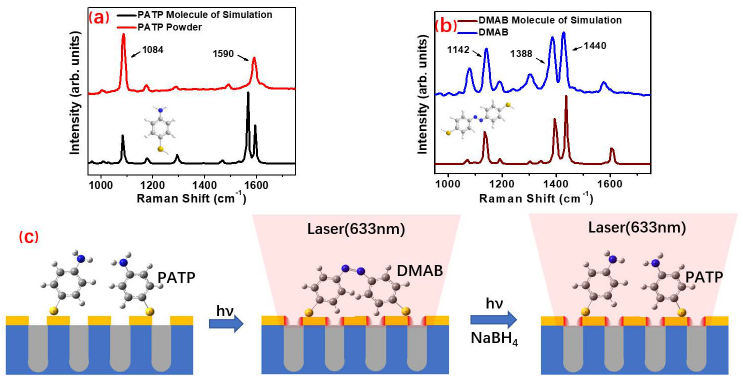
Figure 1. The formation process of DMAB from PATP surface plasma driven photocatalytic reaction: ( a ) PATP Raman characteristic peak; ( b ) DMAB Raman characteristic peak; ( c ) the schematic diagram of the plasma driven photocatalytic